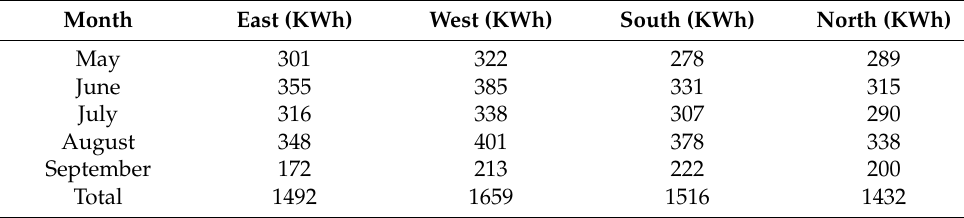
Table 5. The cooling loads during the summer by building orientation. Figure 6. Cooling loads per building orientation during the summer.